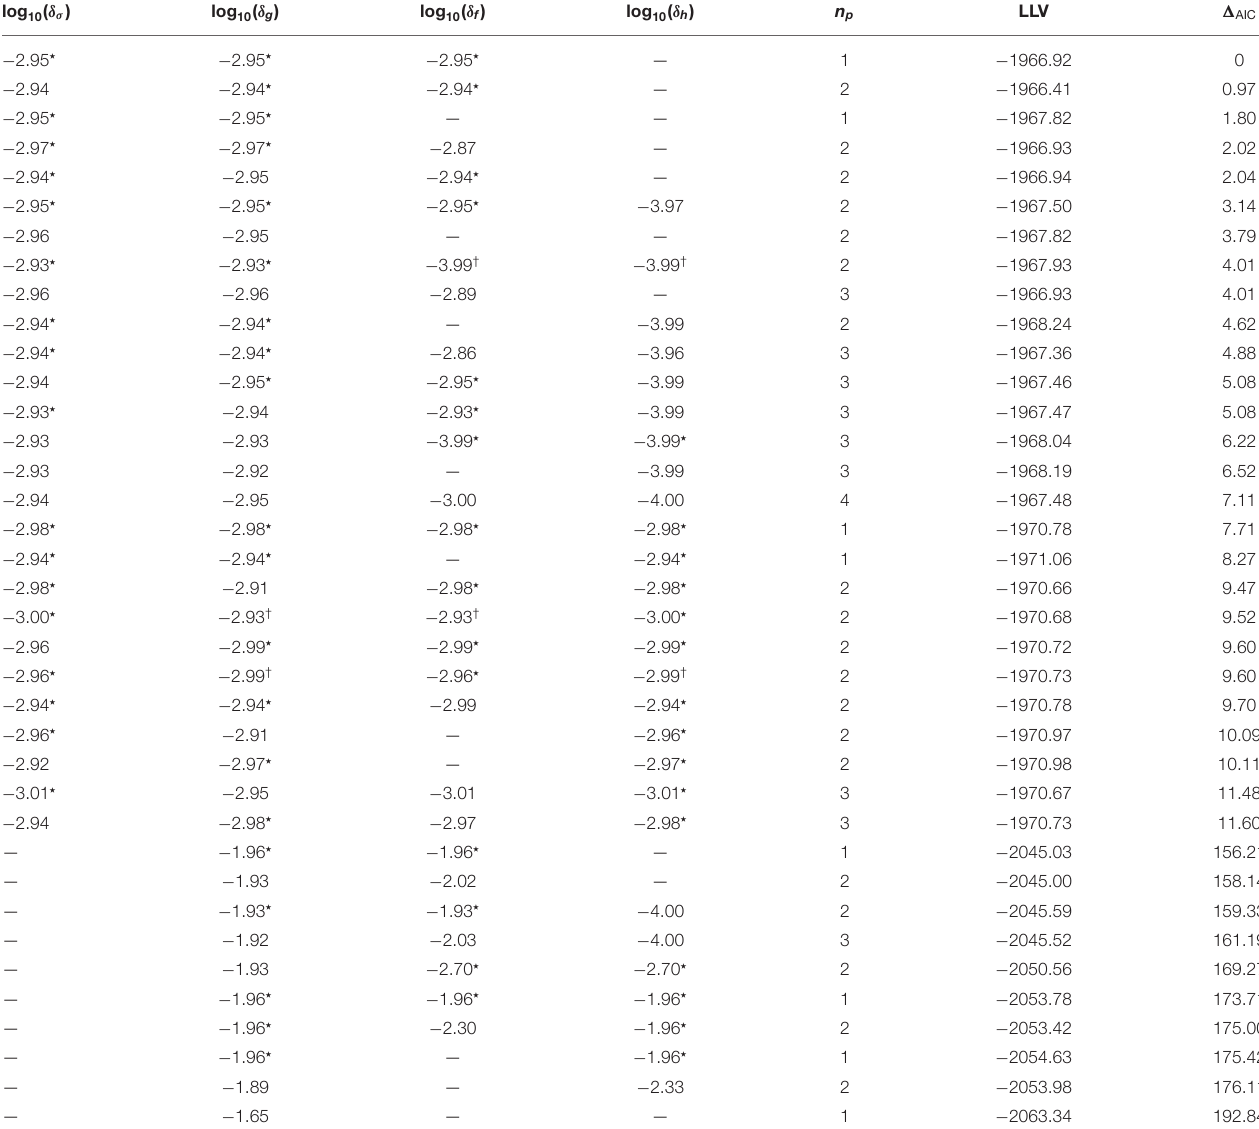
Models are sorted from most to least supported, i.e., according to increasing ∆ AIC scores ( ∆ AIC = 0 refers to the best candidate model). Parameters whose values have been constrained to be equal in the calibration process are marked with the same superscript symbol, while “—” indicates parameters that are set to zero (no density dependence for that model component). All δ ’s are in units of (shoots m − 2 ) − 1